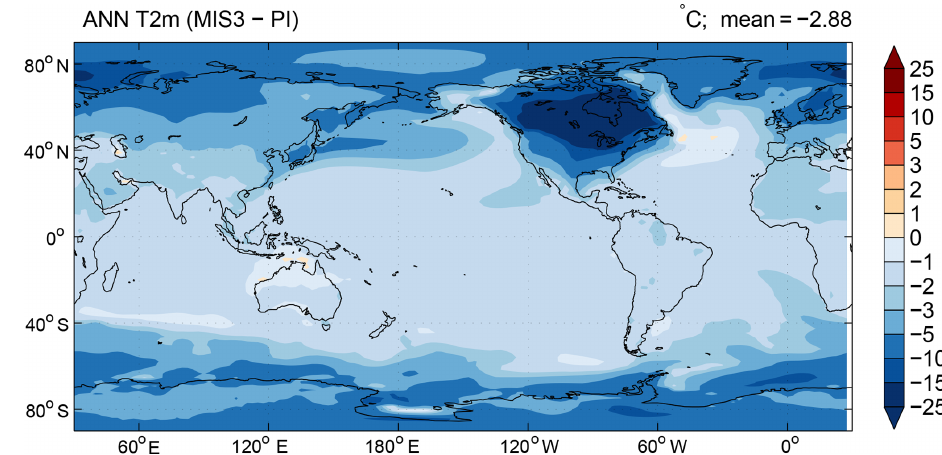
Figure 4. Simulated MIS3 minus PI annual mean near-surface air temperature ( ◦